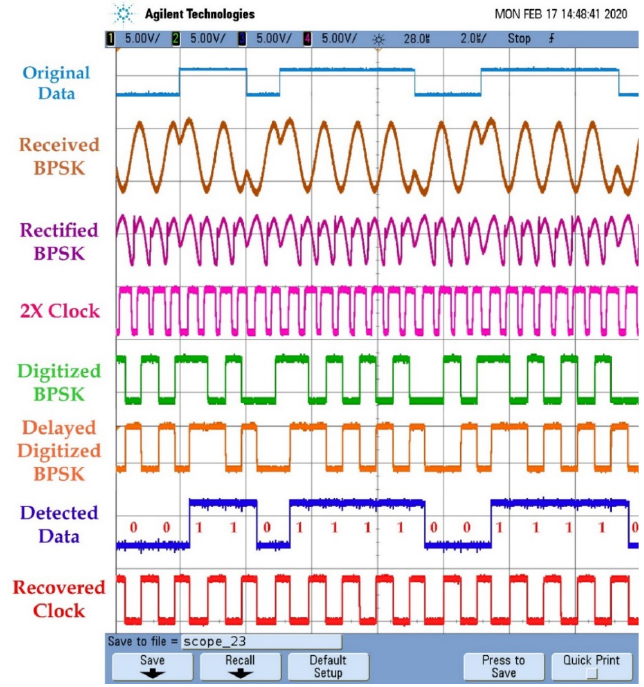
Figure 16. Experimental waveforms that resulted from the proof-of-concept prototype.